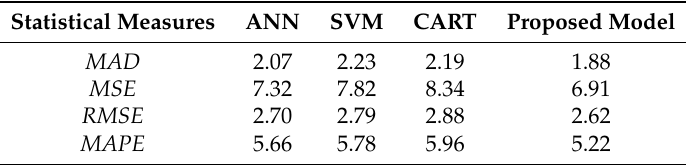
Table 3. Statistical summary of energy consumption prediction (kWh) results using ANN, SVM, CART and Proposed